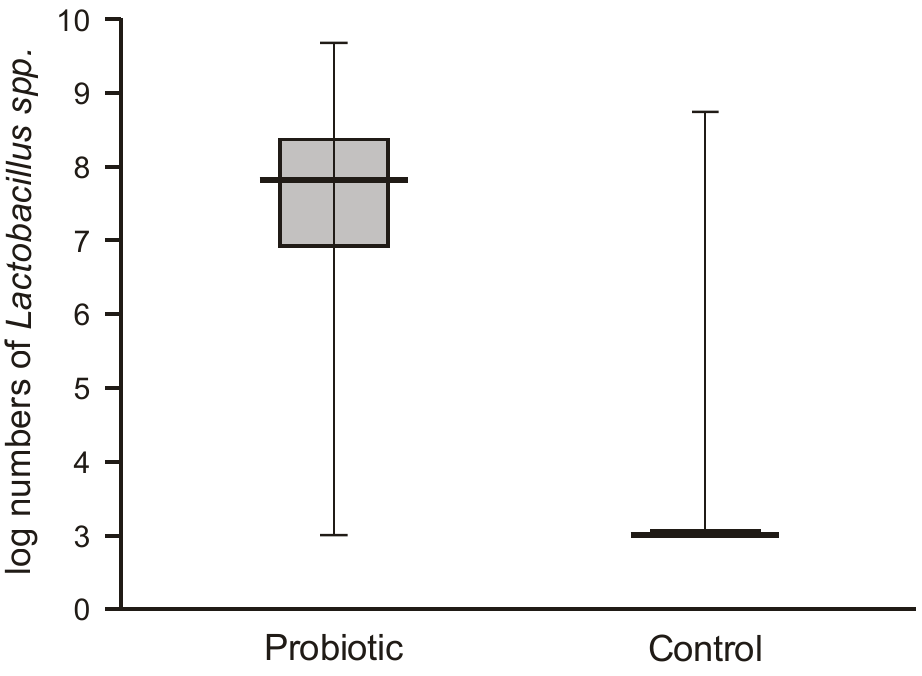
Figure 2. Abundance of lactobacilli in feces obtained from the first sampling of neonates supplemented with probiotics vs. controls (Mann–Whitney test Z = 8.9629; p < 0.00001) Nutrients 2020 , 12 , x FOR PEER REVIEW The numbers of lactobacilli were high and varied from 6.8 to 8.5 logs per gram of feces. Molecular identification confirmed that the isolated lactobacilli belonged to the species L. rhamnosus . The numbers of Bifidobacteria in the feces of the probiotic intervention group were also high, ranging from 4.5 to 8.8 logs/g, which were significantly higher than those detected in the control infants (Figure 3). Molecular identification confirmed that the isolated Bifidobacteria belonged to the B. breve species. Low populations (cumulative counts between 2 and 6 logs/g) of potentially pathogenic cultivable bacteria ( Clostridium , Staphylococcus , Enterococcus , Klebsiella , and Escherichia coli ) were found in the feces samples of both groups, with no significant differences detectable between the groups.